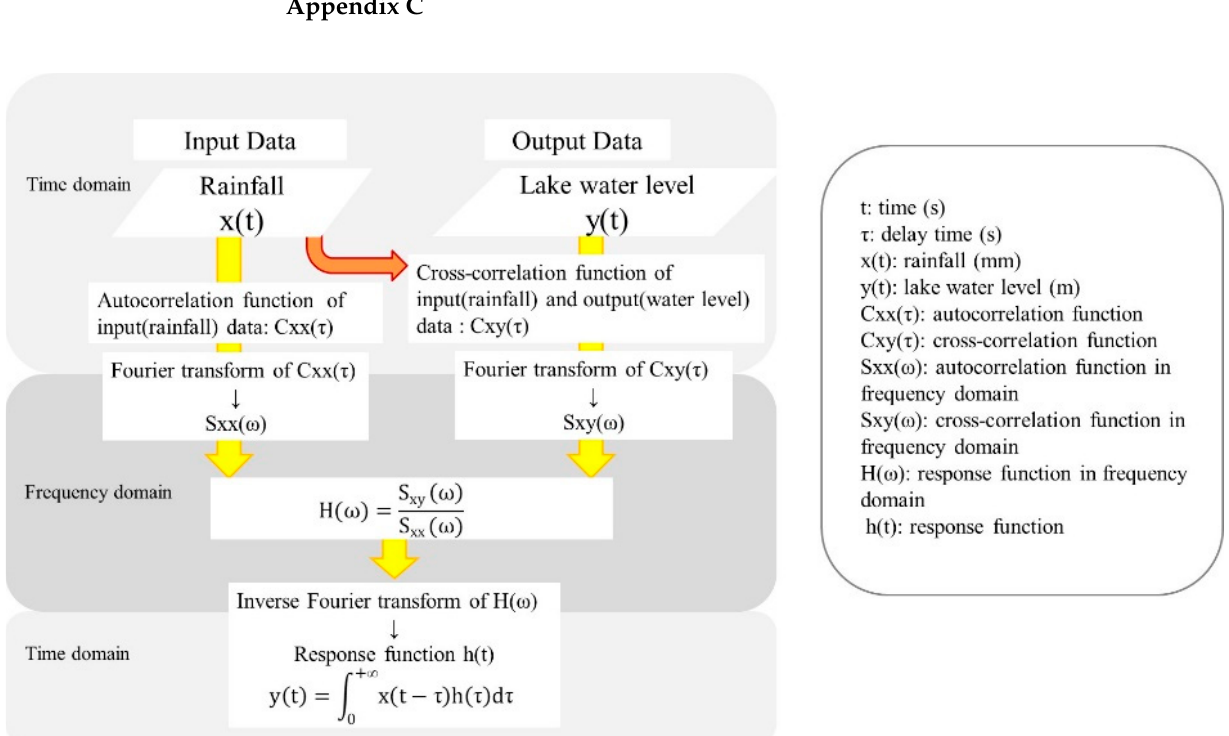
Figure A2. Flowchart showing the response function calculation [6].